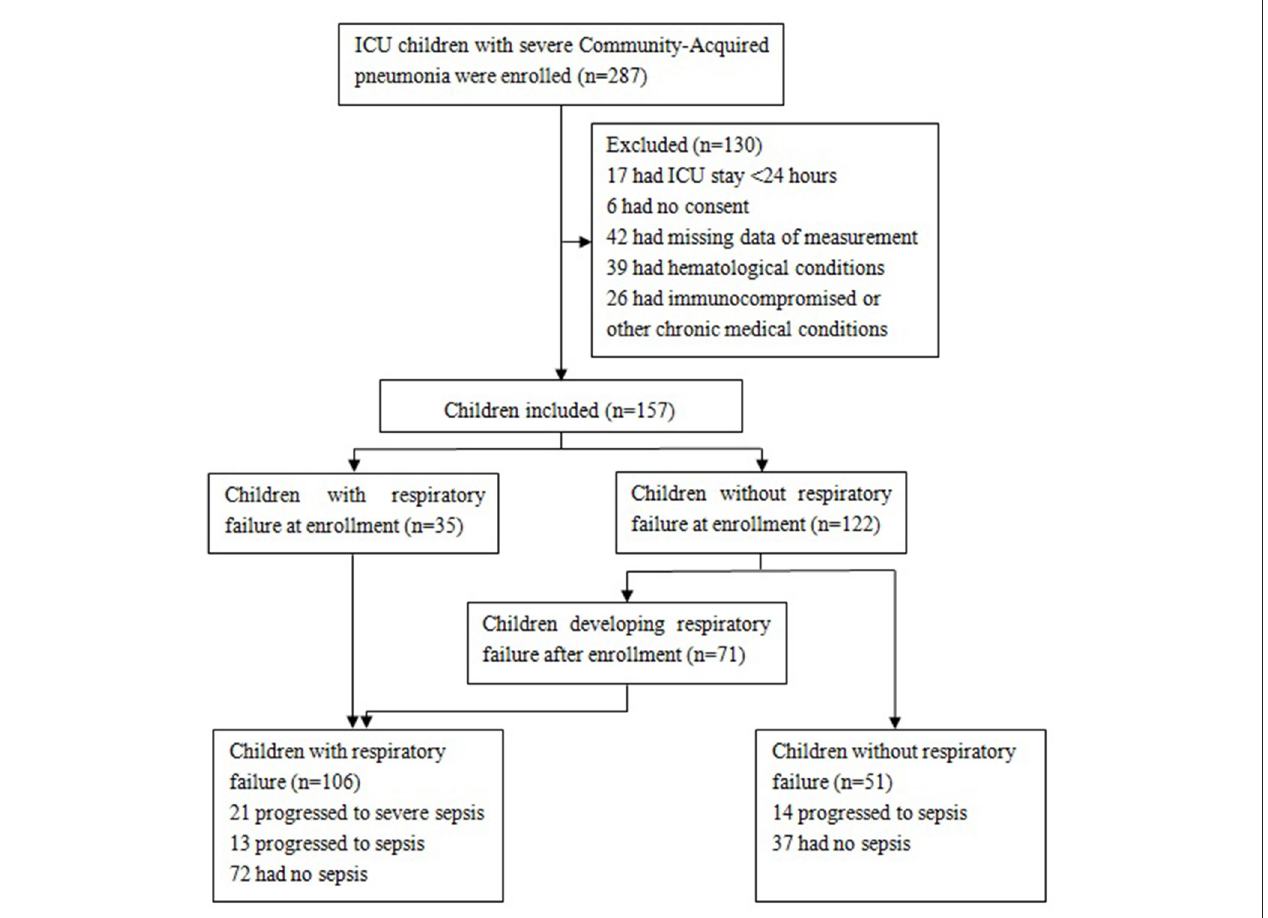
FIGURE 1 | Flowchart of participants. Patients with severe sepsis included those with septic shock ( n = 10) and those without septic shock ( n = 11).